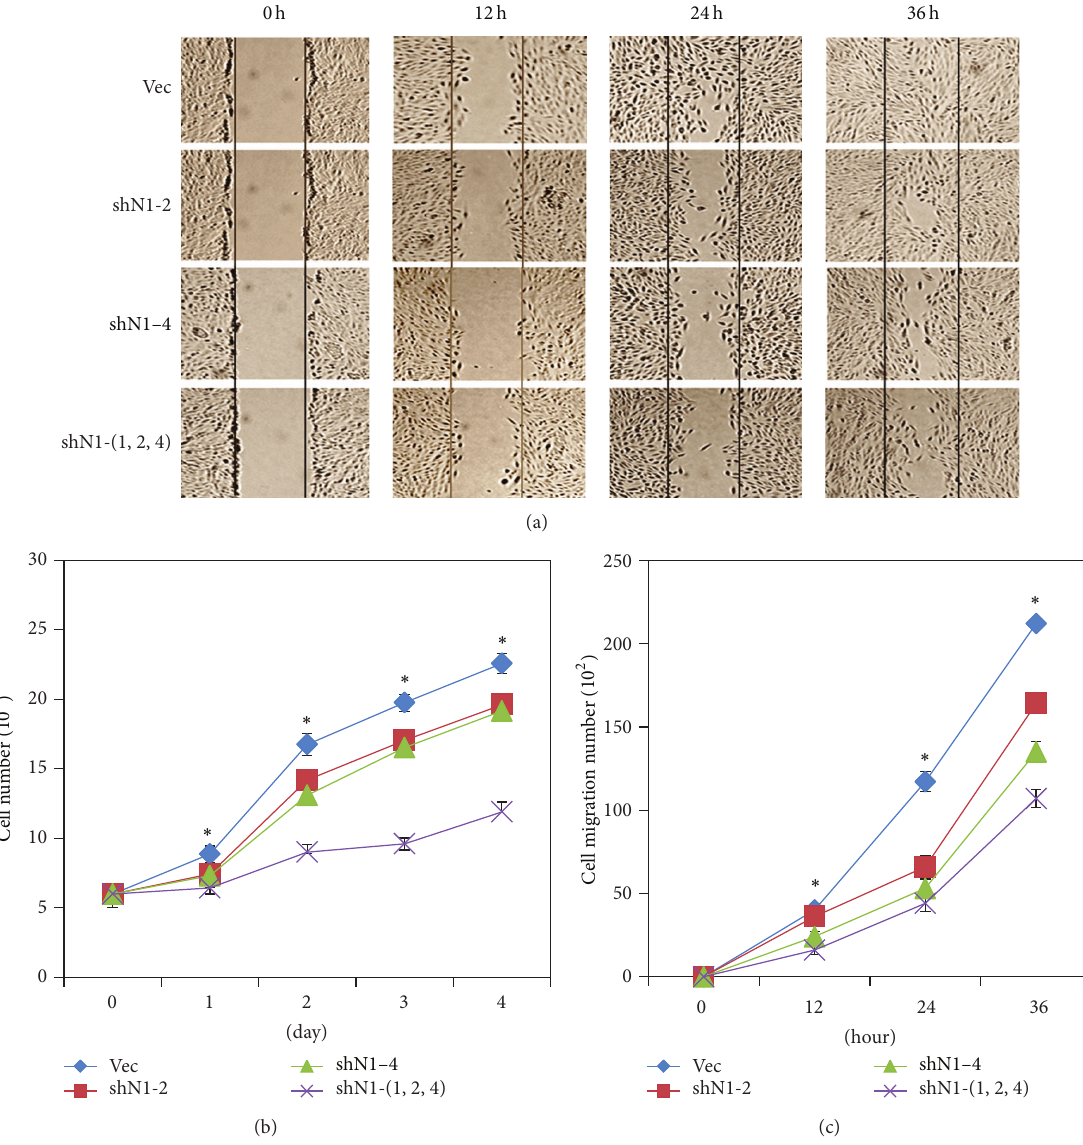
Figure 3: Knockdown of NOTCH1 inhibited the migration and proliferation of RPE cells. (a) The migratory ability of RPE cells was analyzed usingthescratchassay. Themigrationof RPEcell lines wasinhibited afterNOTCH1was knocked down (24hand 36h). (b)Cellsthat migrated to the scratch wound were counted. The cell line shN1-(1, 2, 4) exhibited the lowest number of cells that migrated to the scratch area when compared to control cells. (c) RPE cell proliferation was determined by cell counting for four days. Data are presented as average values ± SD. The cell line shN1-(1, 2, 4) showed the slowest proliferation rate. Data are expressed as means ± SD. ∗ 𝑃 < 0.05 versus vehicle and error bars represent at least two independent